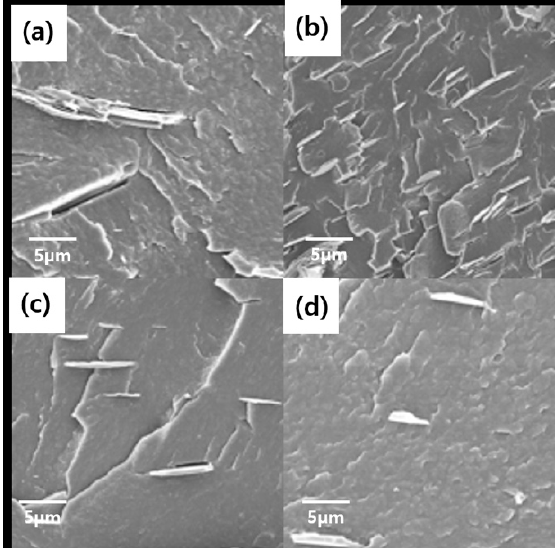
Figure 9. Cross-section image of BN/PPA composites raw BN ( a ), BNNs–A ( b ), BNNs–B ( c ) and BNNs–C ( d ).